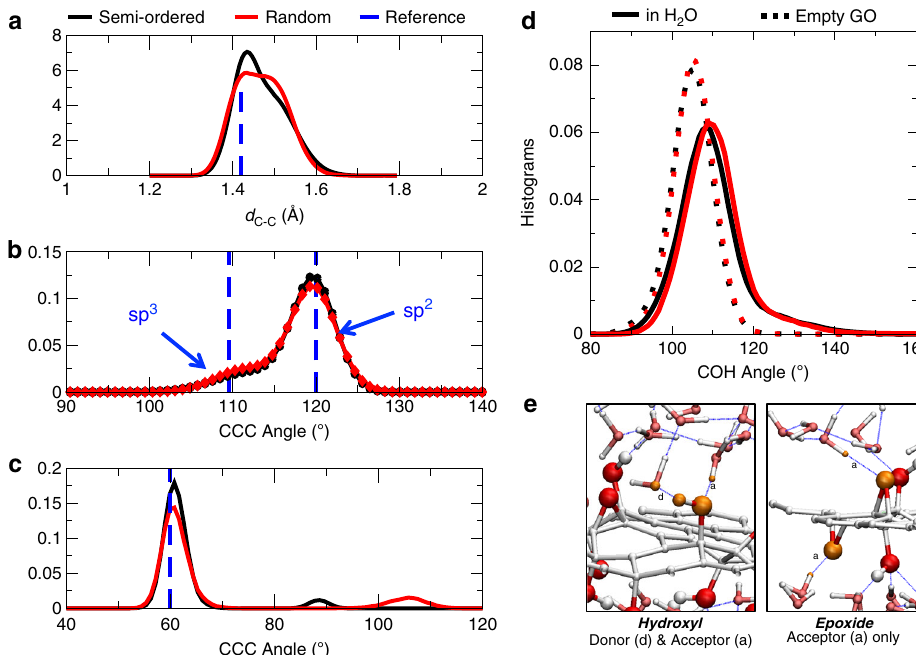
Fig. 2 Structural properties of graphene oxide. Histograms of the C – C distance d C – C ( a ), the d CCC angle ( b ), and the d COC angle ( c ) for semiordered (black) and random (red) graphene oxide models. Blue dashed lines correspond to the values in reference systems: d C – C = 1.42 Å in graphene, d CCC ¼ 109 : 28 (cid:3) , d CCC ¼ 120 (cid:3) , and d COC ¼ 60 (cid:3) for epoxide. d Histogram of the d COH angle for the GO in vacuum (dashed lines) and GO solvated in sp 3 sp 2 water (solid lines). e Snapshots of the different H bonds (visualized as blue dashed lines) types classi fi ed in Table 3. The atoms of each type of chemical function (hydroxyl group or epoxide) involved in the H bonds between the surface and H 2 O are highlighted in